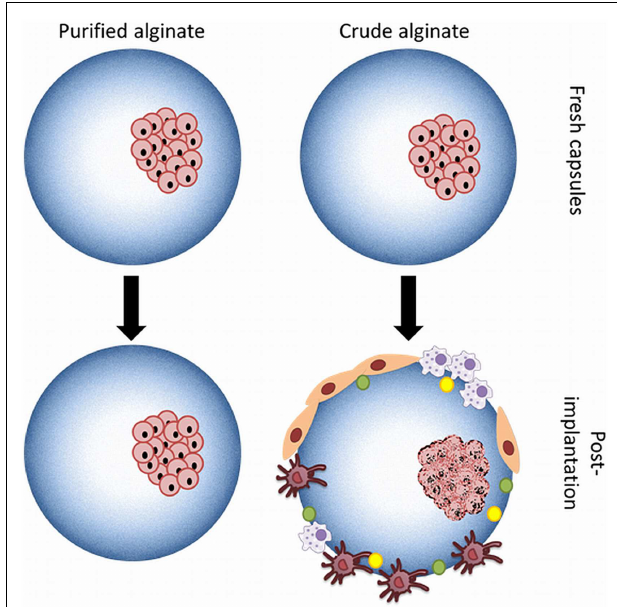
FIGURE 6 | Microcapsules produced with purified or crude alginate . Use of crude alginate or alginates containing PAMPs promotes after implantation activation of the host immune system with recruitment of immune-cells as a consequence. Necrosis of the islet-cells is an inevitable